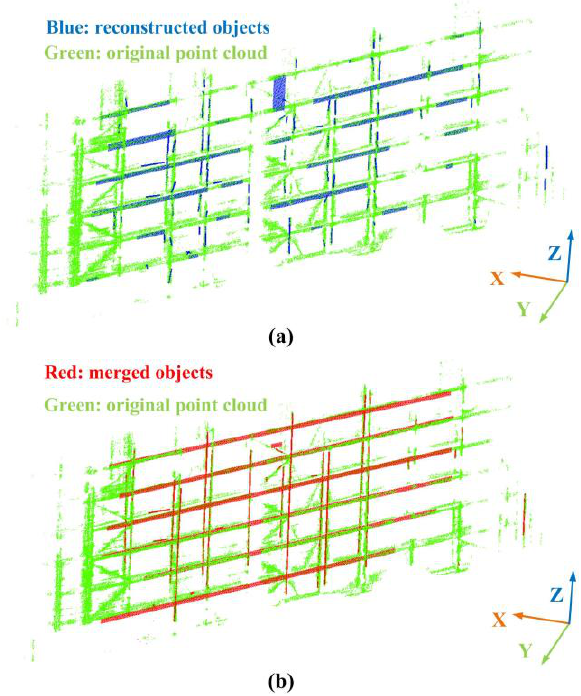
Figure 14. The matching results of the façade, a) the reconstructed objects (blue) and the original point clouds (green), b) the merged reconstructed objects (red) and the original point cloud (green).